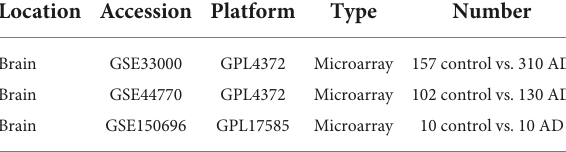
TABLE 1 Dataset information from the GEO